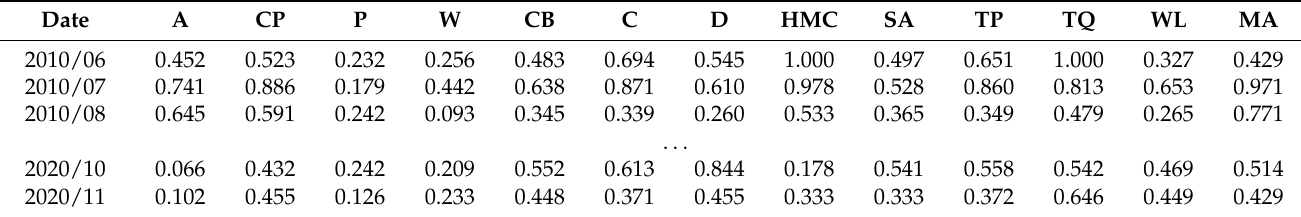
Table 2. Normalized results.